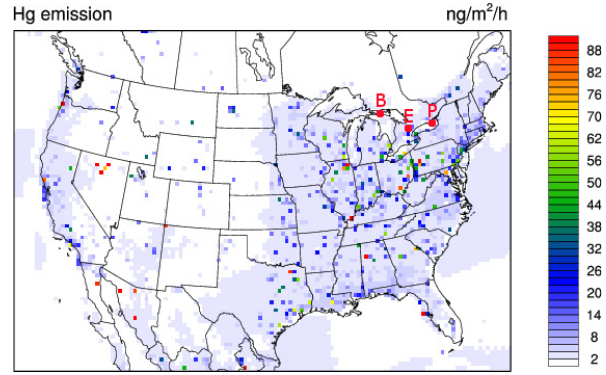
Fig. 1. Simulation domain and the locations of the three monitoring sites: Burnt Island (B), Egbert (E) and Point Petre (P). Annual av- erage Hg emission rate including anthropogenic and natural Hg for